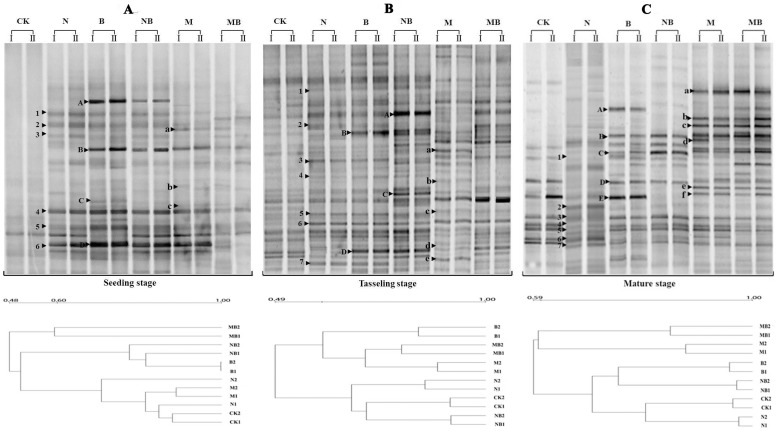
DGGE banding patterns of 16S bacteria fragment and clustering of DGGE profiles in various treatments during maize growth stages.CK: no fertilizer; N: N fertilizer; B: bacteria fertilizer; NB: N fertilizer + bacteria fertilizer; M: manure compost; MB: manure compost + bacteria fertilizer.